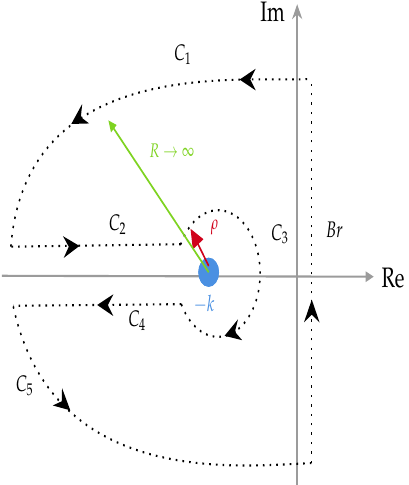
Figure A1. Integration path of Example